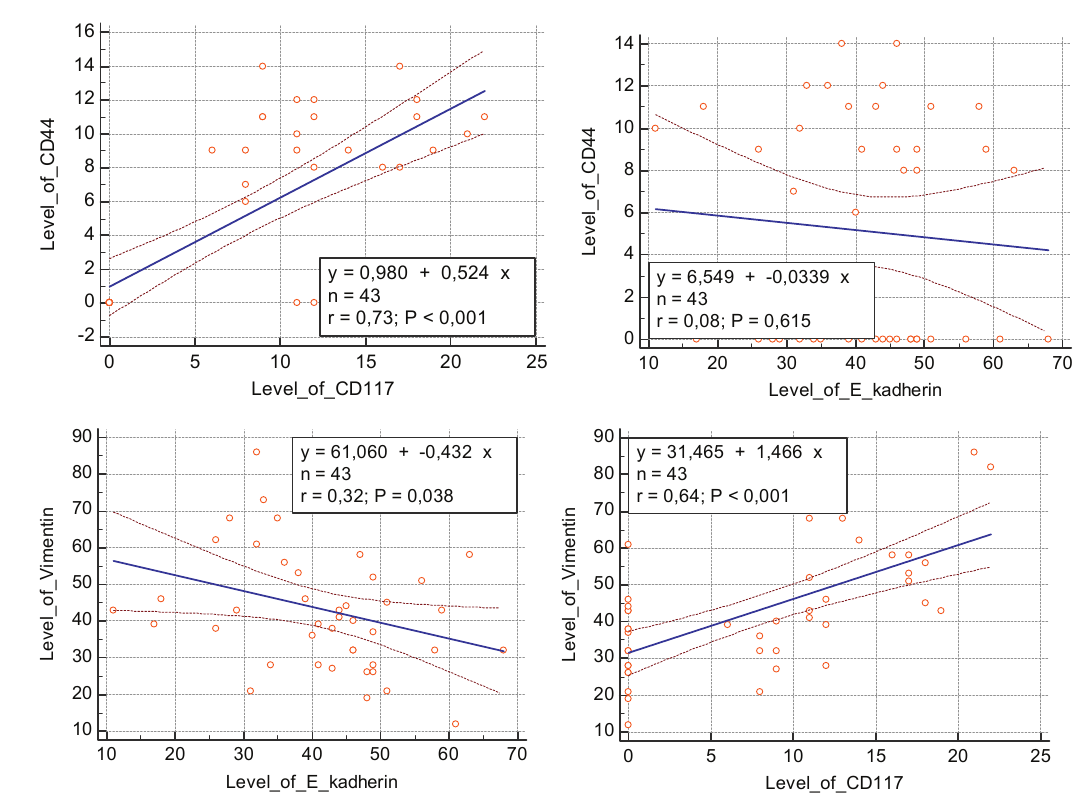
Fig. 5. Graphical representation of the correlations between the studied markers of EMT and